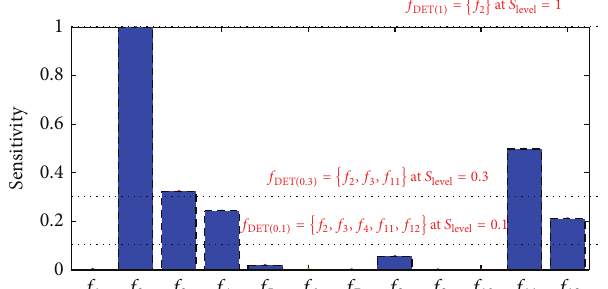
Figure 7: Sensitivity of fault features by means of the conventional